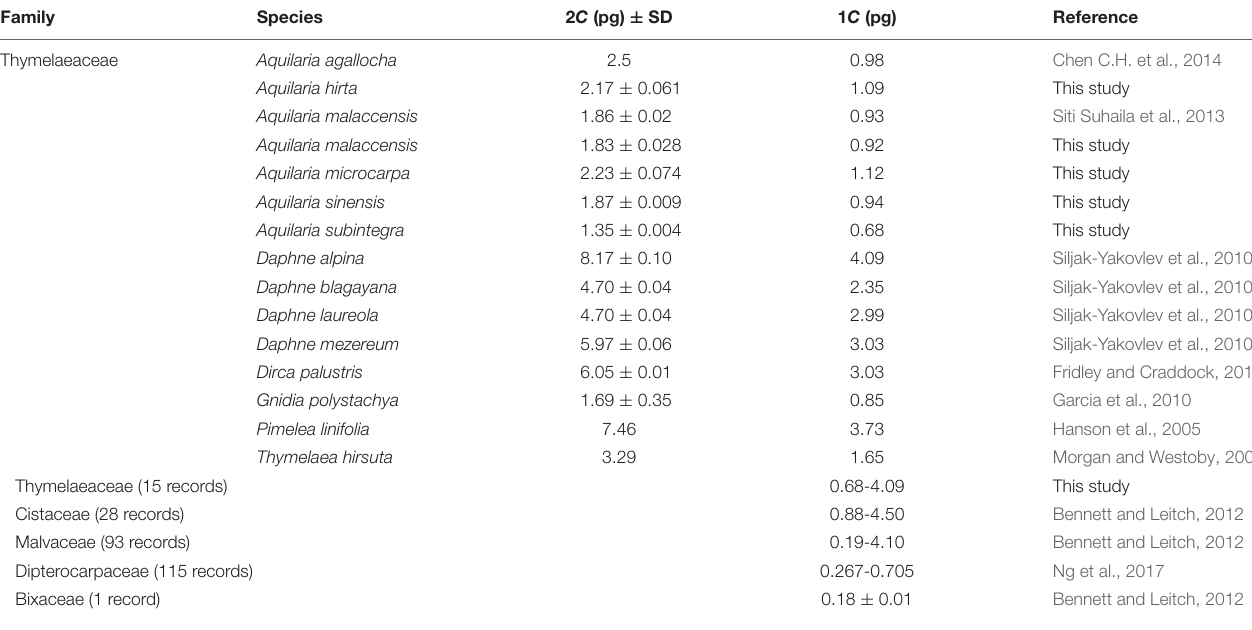
TABLE 1 | Genome size of species used in this study and their closely related genera and